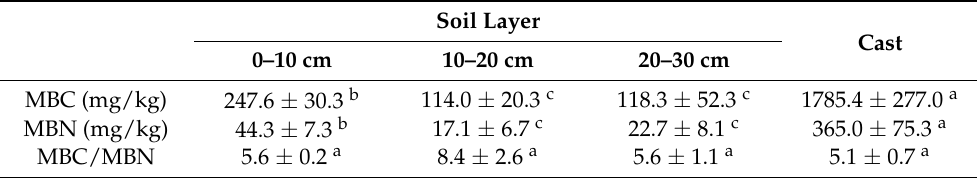
Table 2. Concentrations of microbial biomass carbon (MBC) and nitrogen (MBN) in bulk mineral soils and surface earthworm casts (means ± SE, n = 5). Samples were collected in May 2016. Different letters represent significant differences among soil layers and casts (LSD test, P <